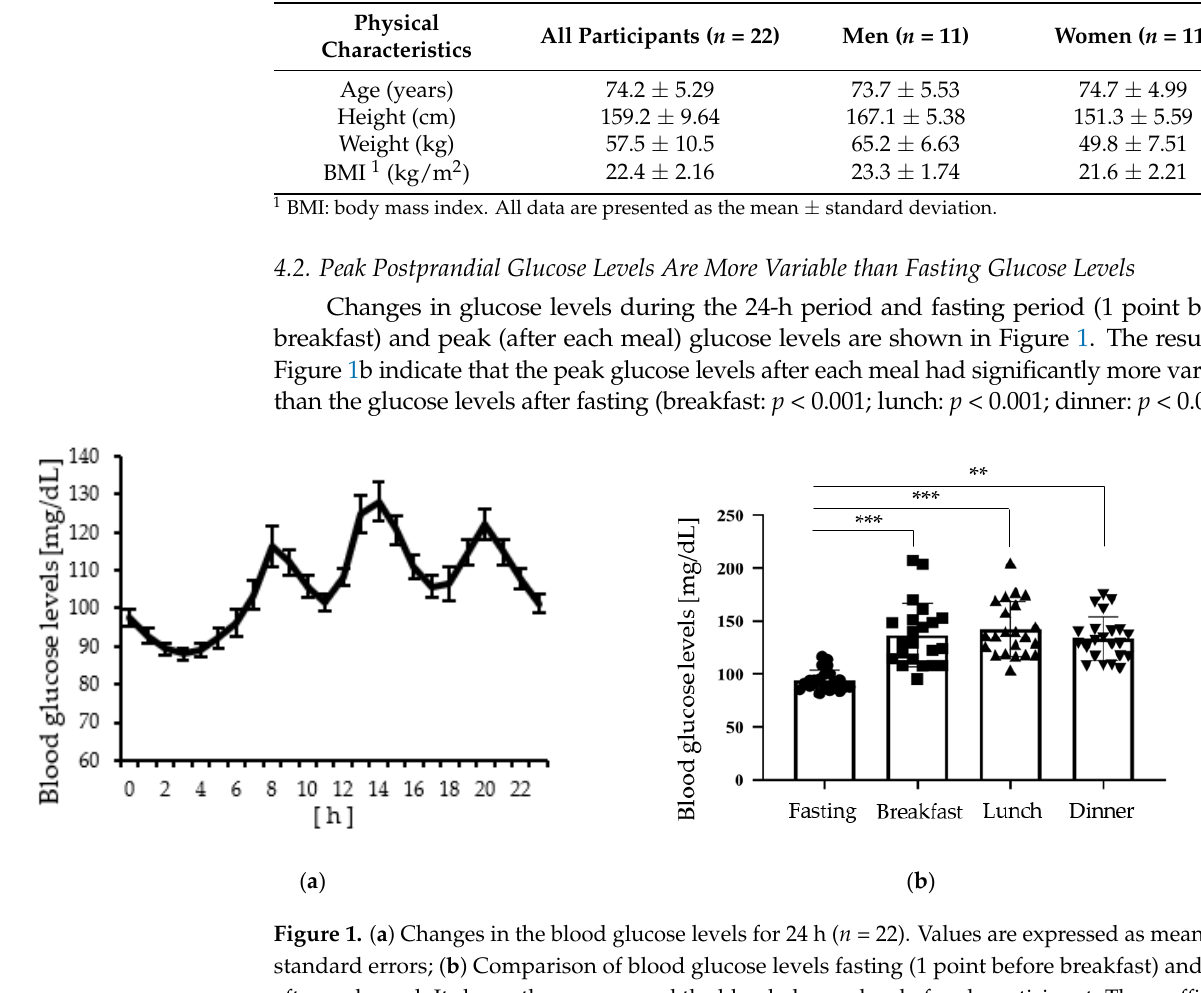
*** p < 0.001, vs. Fasting (Levene’s